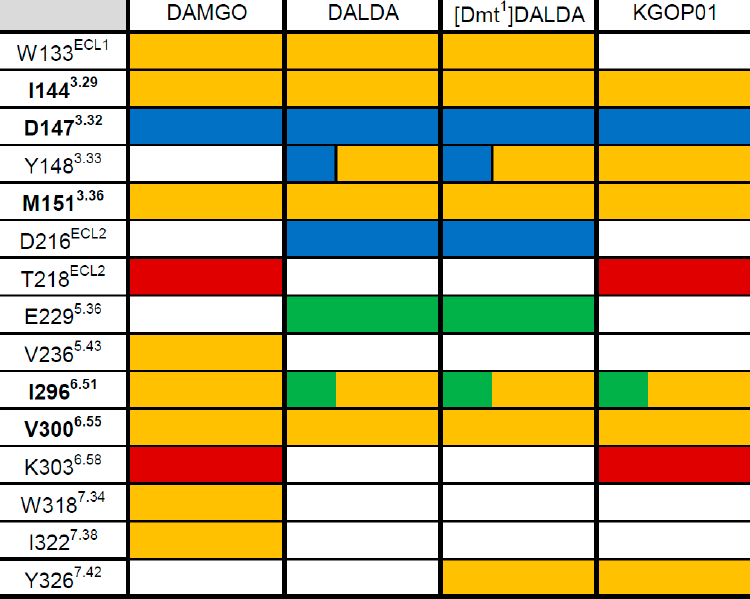
Figure 8. Hydrophobic environment of Dmt moieties of [Dmt 1 ]DALDA (light grey) and KGOP01 (dark grey). The two methyl groups show additional hydrophobic contacts with Y148 3.33 and Y326 7.32 , respectively, which are not observable for DAMGO or DALDA. Yellow spheres indicate lipophilic contacts and green arrows hydrogen bond donors. For clarity, only interactions of the Dmt moiety are shown. 3. Materials and Methods 3.1. Chemicals and Materials Cell culture media and supplements were obtained from Sigma-Aldrich Chemicals (St. Louis, MO, USA). Radioligands [ 3 H]DAMGO (50 Ci/mmol) and [ 35 S]GTP γ S (1250 Ci/mmol) were purchased from PerkinElmer (Boston, MA, USA). DAMGO, unlabeled GTP γ S, and guanosine